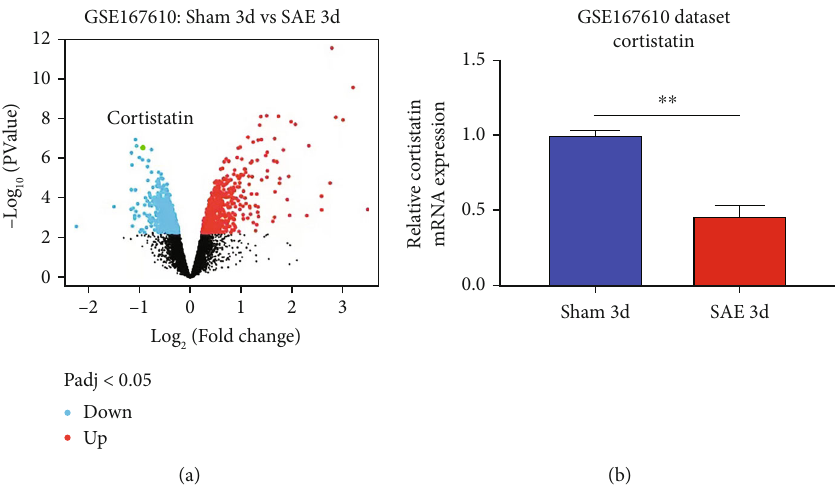
Figure 1: Analysis of the SAE-related murine brain mRNA dataset GSE167610. (a) Volcano plot of di ff erentially expressed RNA between (|FC| > 1, P < 0.05). (b) Decreased cortistatin mRNA expression in the SAE mouse brain compared to sham mouse